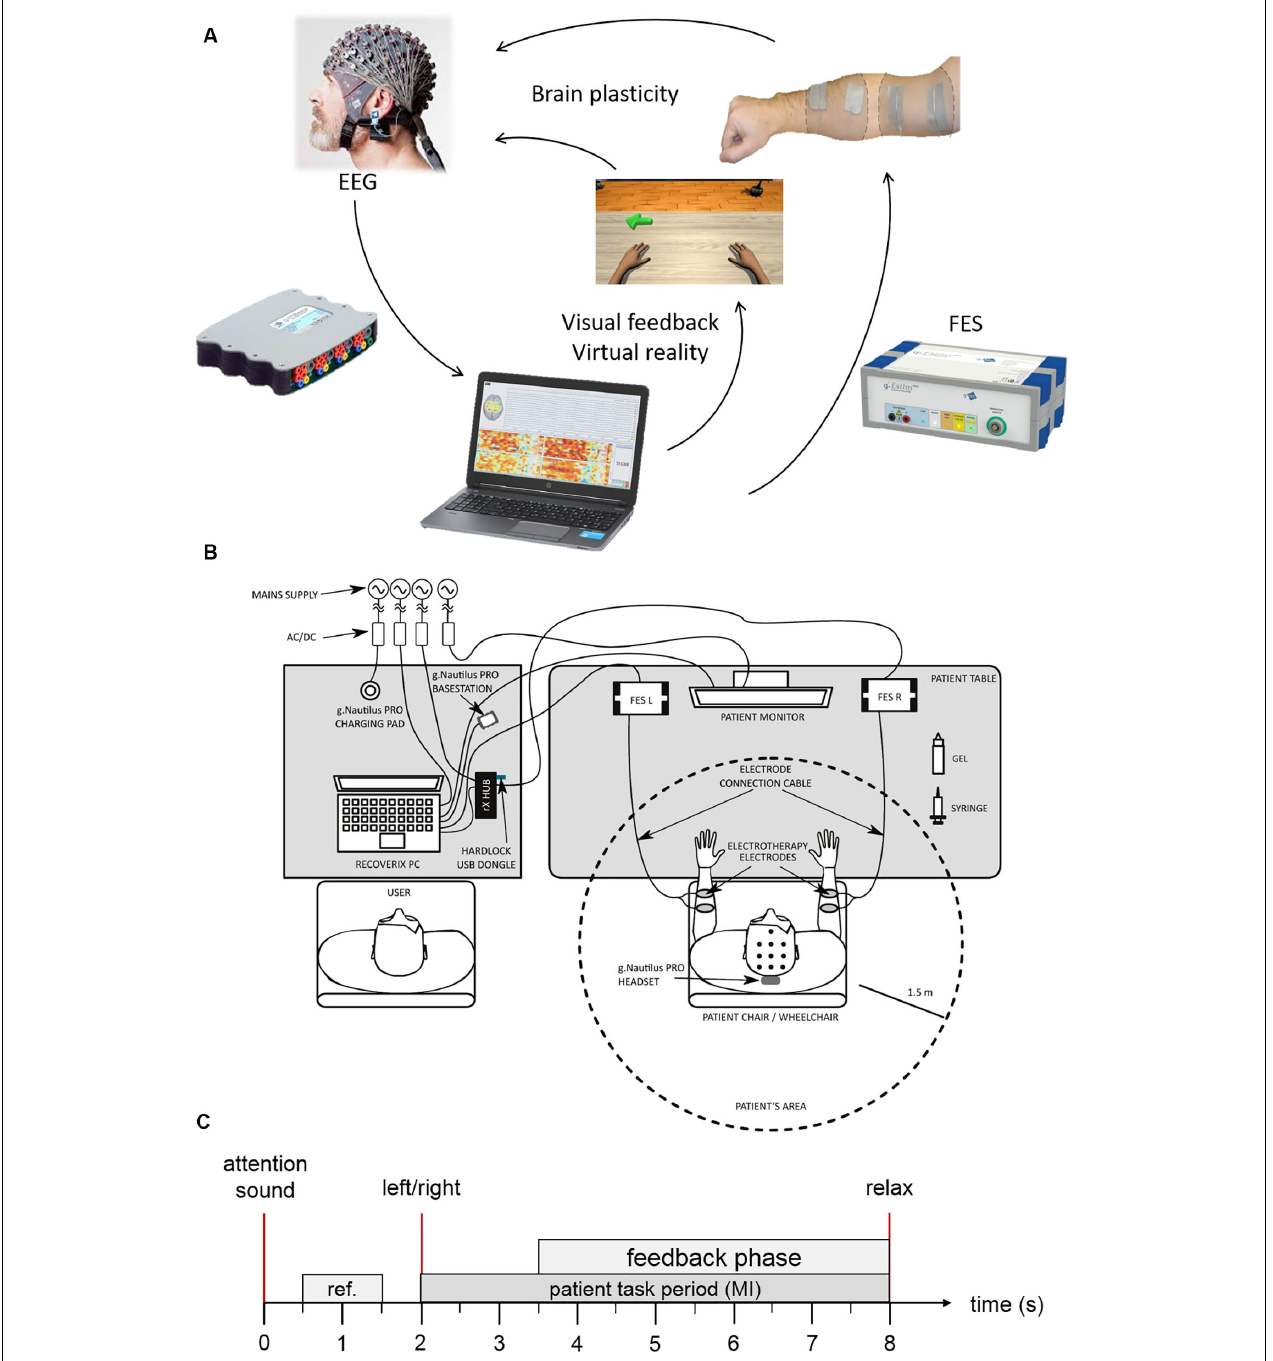
FIGURE 1 | BCI system components. (A) Shows the motor learning loop. (B) System setup. (C) Trial